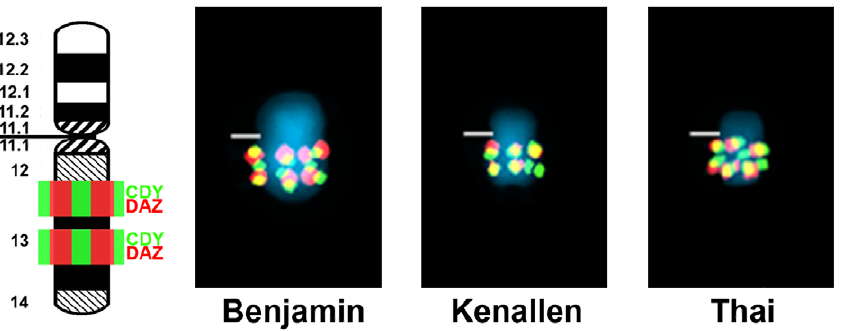
Figure 2. FISH mapping of ampliconic genes DAZ and CDY on Y chromosomes of Bornean orangutan. FISH patterns for DAZ (red) and CDY (green) illustrated for the Bornean orangutans ‘‘Benjamin’’, ‘‘Thai’’ and ‘‘Kenallen’’. The band locations of each gene are shown on the ideograms to the left. Yellow signals result from overlapping of red and green signals. Centromeres are marked by horizontal lines. Band nomenclature follows the ISCN [71].